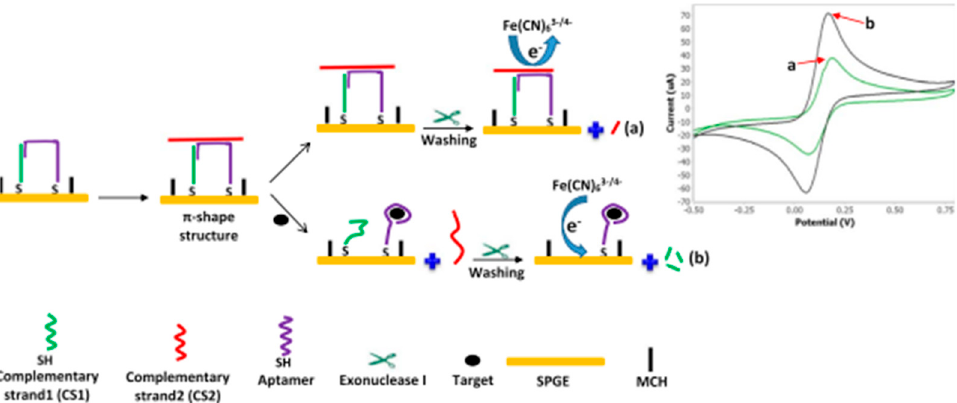
Figure 6. Fabrication process of the developed π -shape electrochemical aptasensor for AFB1. In the absence of AFB1, most parts of the π -shape structure were intact, and redox mediator did not have access to the surface of electrode, leading to a weak current signal ( a ). In the presence of AFB1, Apt bound to AFB1 and left the CSs. Exo I digested CS1, resulting in more access of [Fe (CN) 6 ] 3 − /4 − to the surface of electrode and generated a strong current signal ( b ). Reproduced from [50]. Copyright 2017 Elsevier.